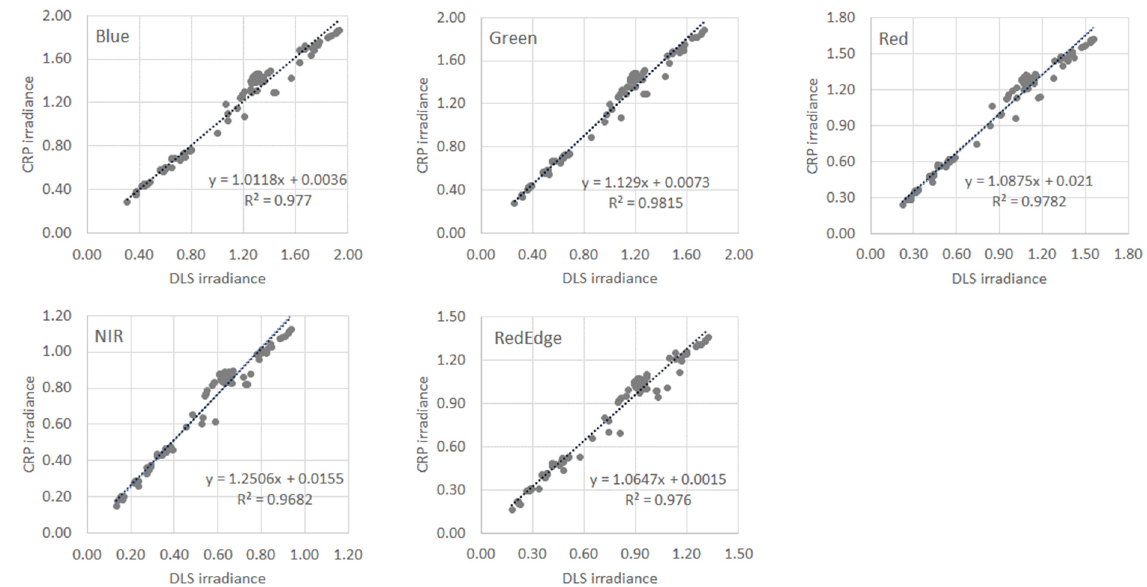
Figure 4. Scatterplots of the CRP and DLS irradiance of the five RedEdgeM bands. All calibration images in the study are utilized (N = 107).